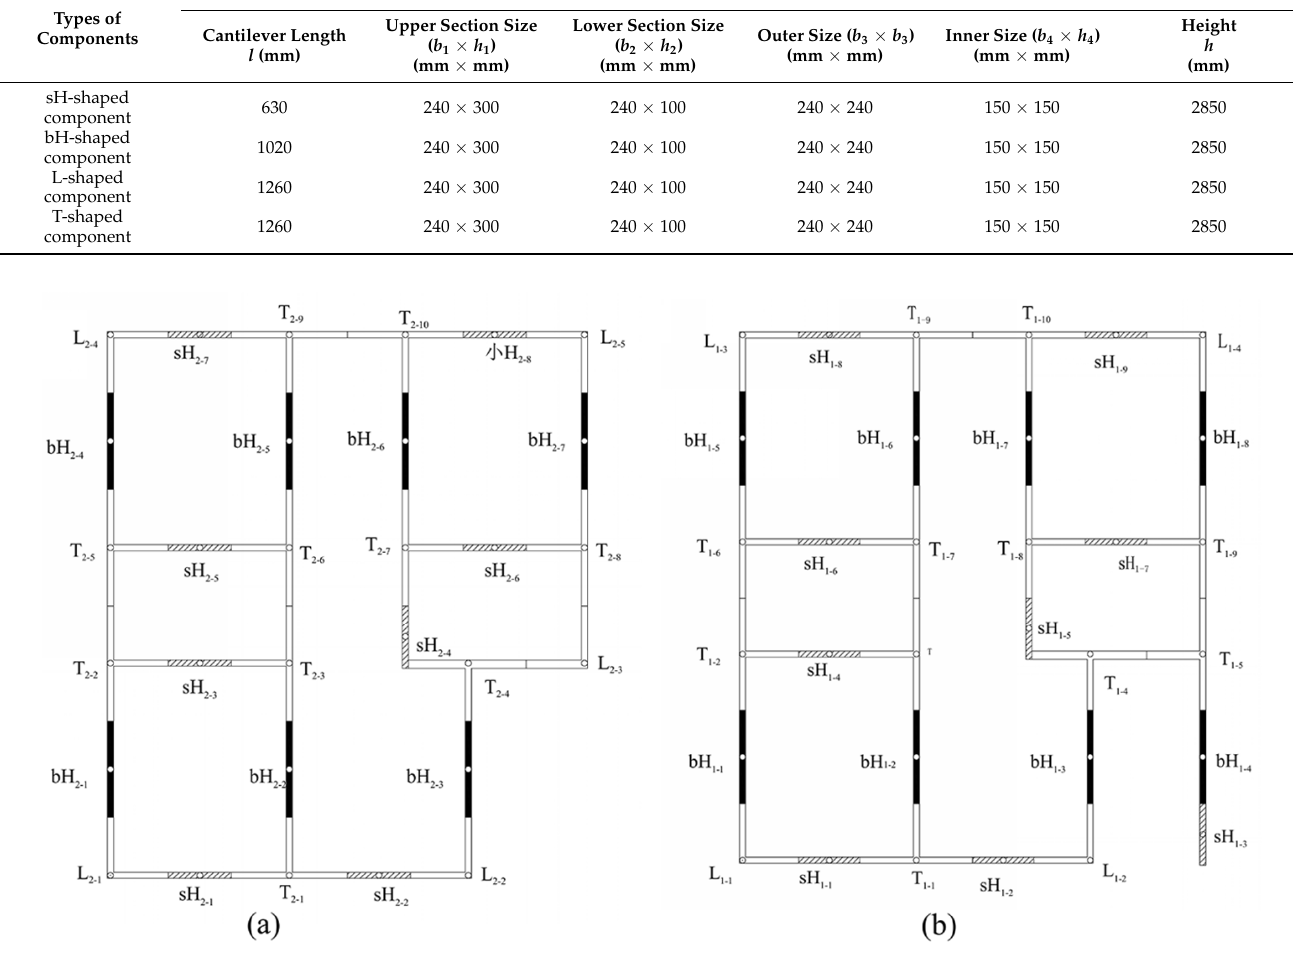
Figure 10. Positions and numbers of various types of prefabricated cantilever components: ( a ) first floor and ( b ) second floor.